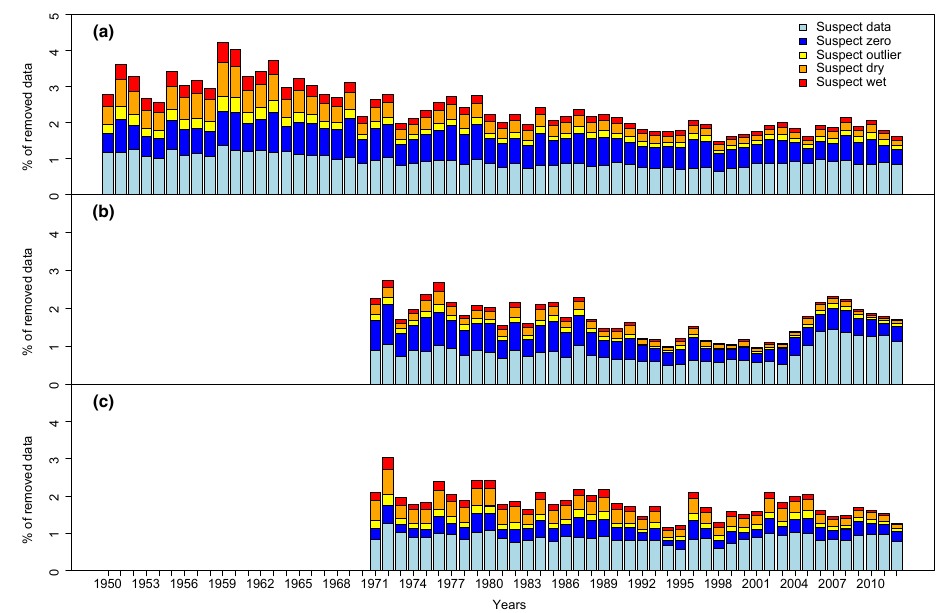
Figure 2. Removed data by criteria (suspect data, suspect zero, suspect outlier, suspect dry day and suspect wet day): (a) peninsular Spain; (b) Balearic Islands and (c) Canary